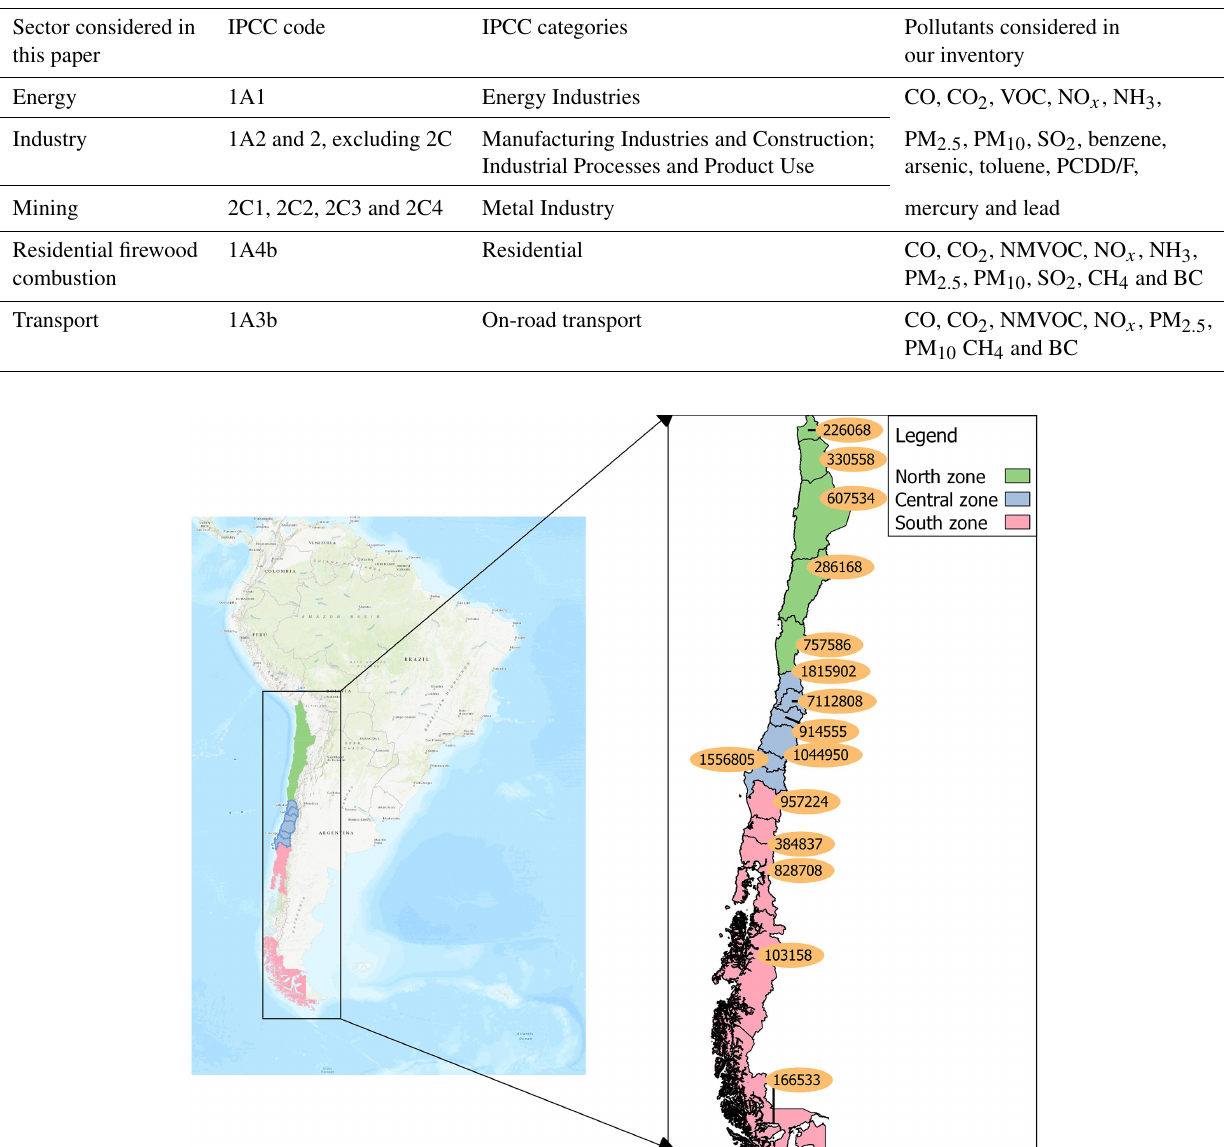
Figure 1. Continental Chile highlighting three macrozones defined for the paper, namely the north (green), central (blue) and south zone (red). Divisions within each macrozone indicate limits of the 16 administrative regions. Population in each of these 16 regions is indicated in the orange